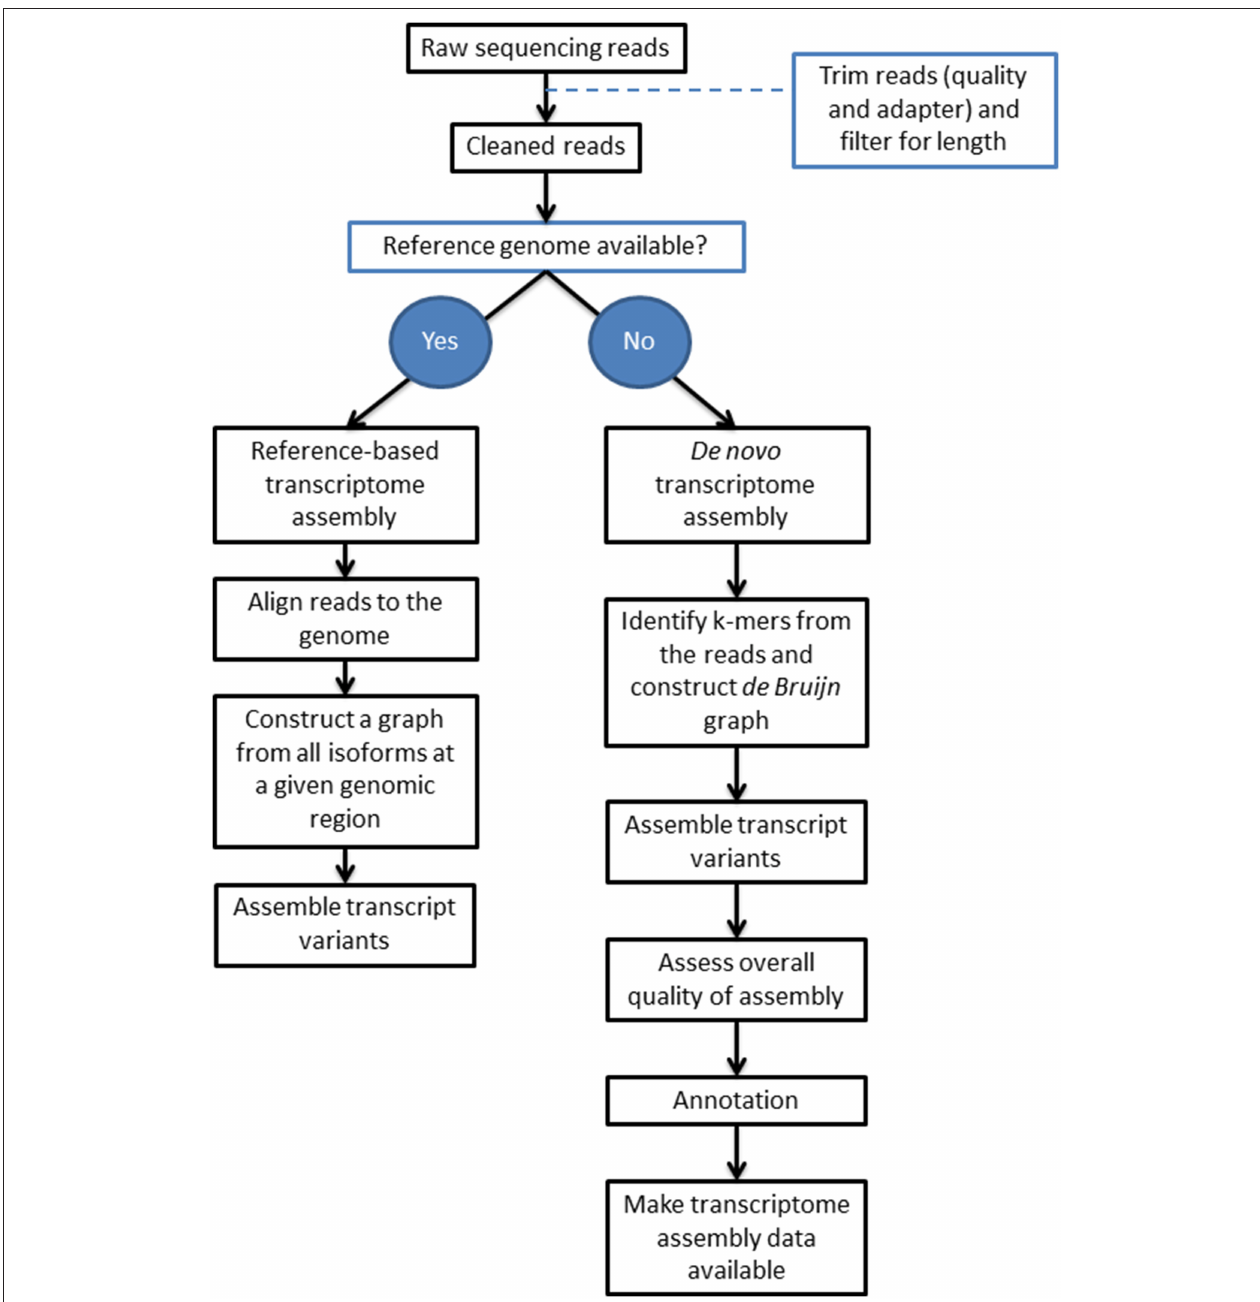
FIGURE 1 | An overview of the two transcriptome assembly pipelines. The key parts of two transcriptome assembly pipelines are shown depending on whether a reference genome is available. This review is focused on de novo transcriptome assembly; more information on the pipeline for reference-based transcriptome assembly can be found in review papers such as Martin and Wang